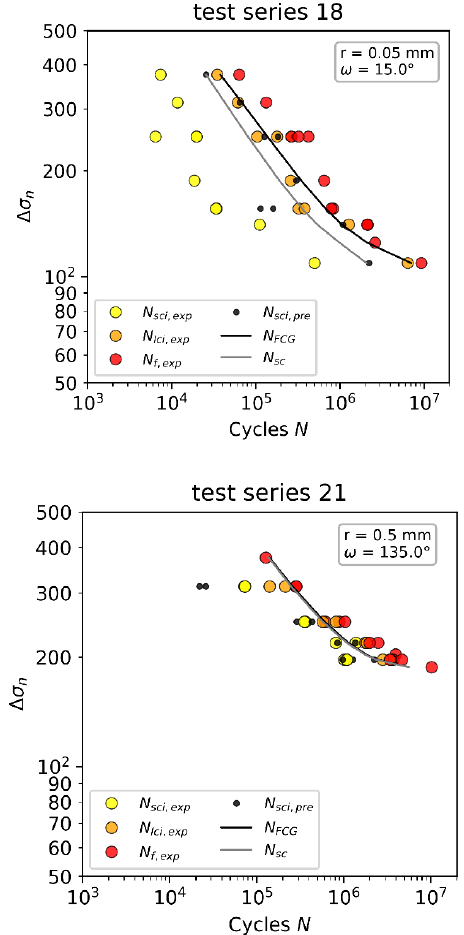
Figure 13. Comparison of S–N data: experimentally derived for three failure criteria, numerically calculated cycles for short crack growth and total crack growth, and derived crack initiation cycles. Material QStE380TM BM.